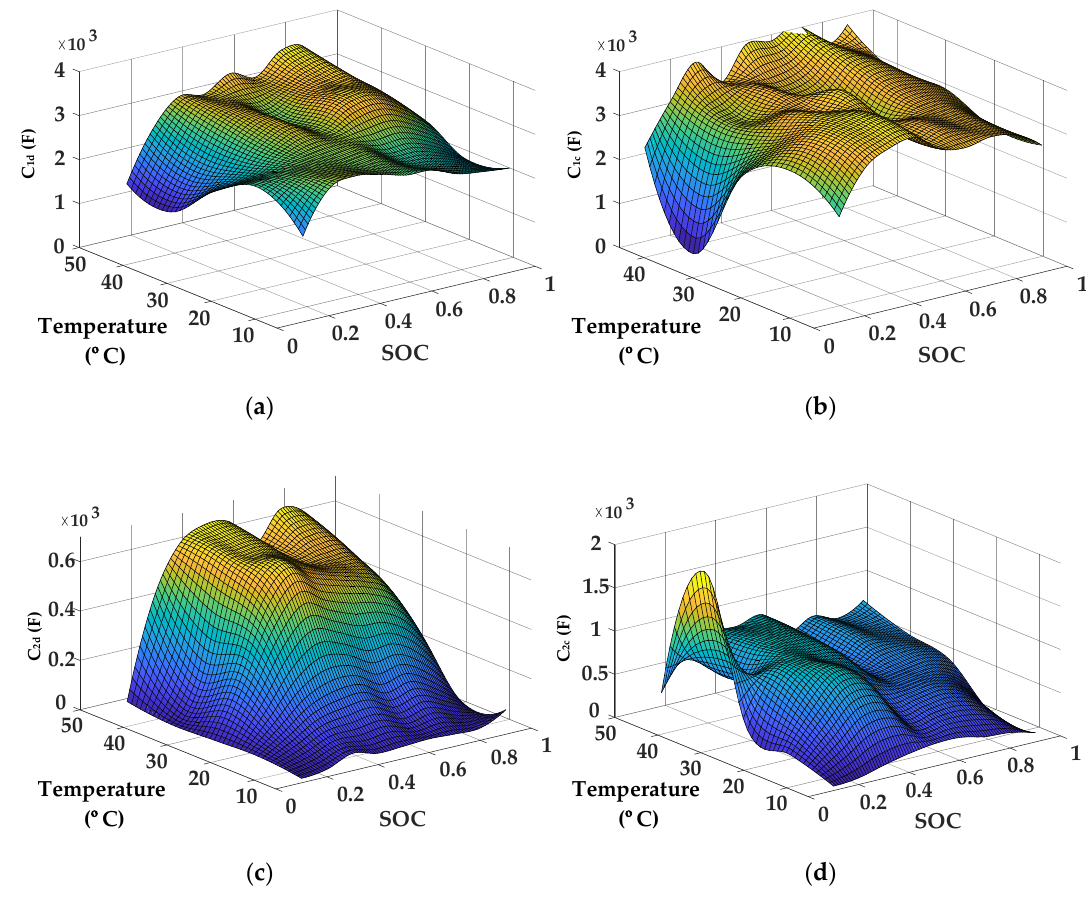
Figure 7. Polarization capacitance identification results: ( a ) identified capacitance for discharging, C 1d ; ( b ) identified capacitance for charging, C 1c ; ( c ) identified capacitance for discharging, C 2d ; and ( d ) identified capacitance for charging, C 2c .